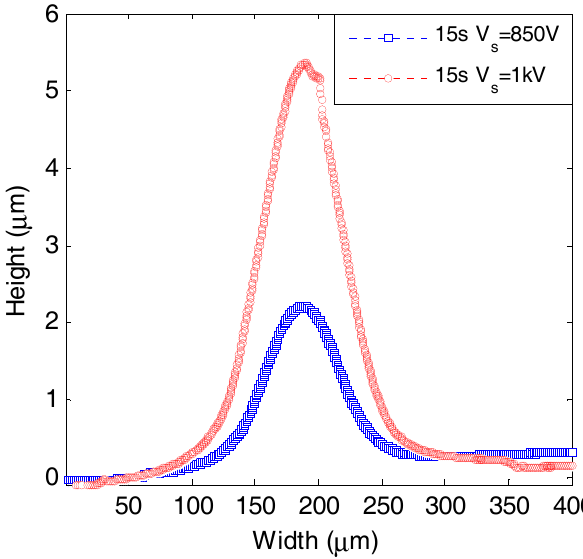
Figure 10. Thickness profiles of deposited films for 15 s at 850 and 1000 V source voltage.